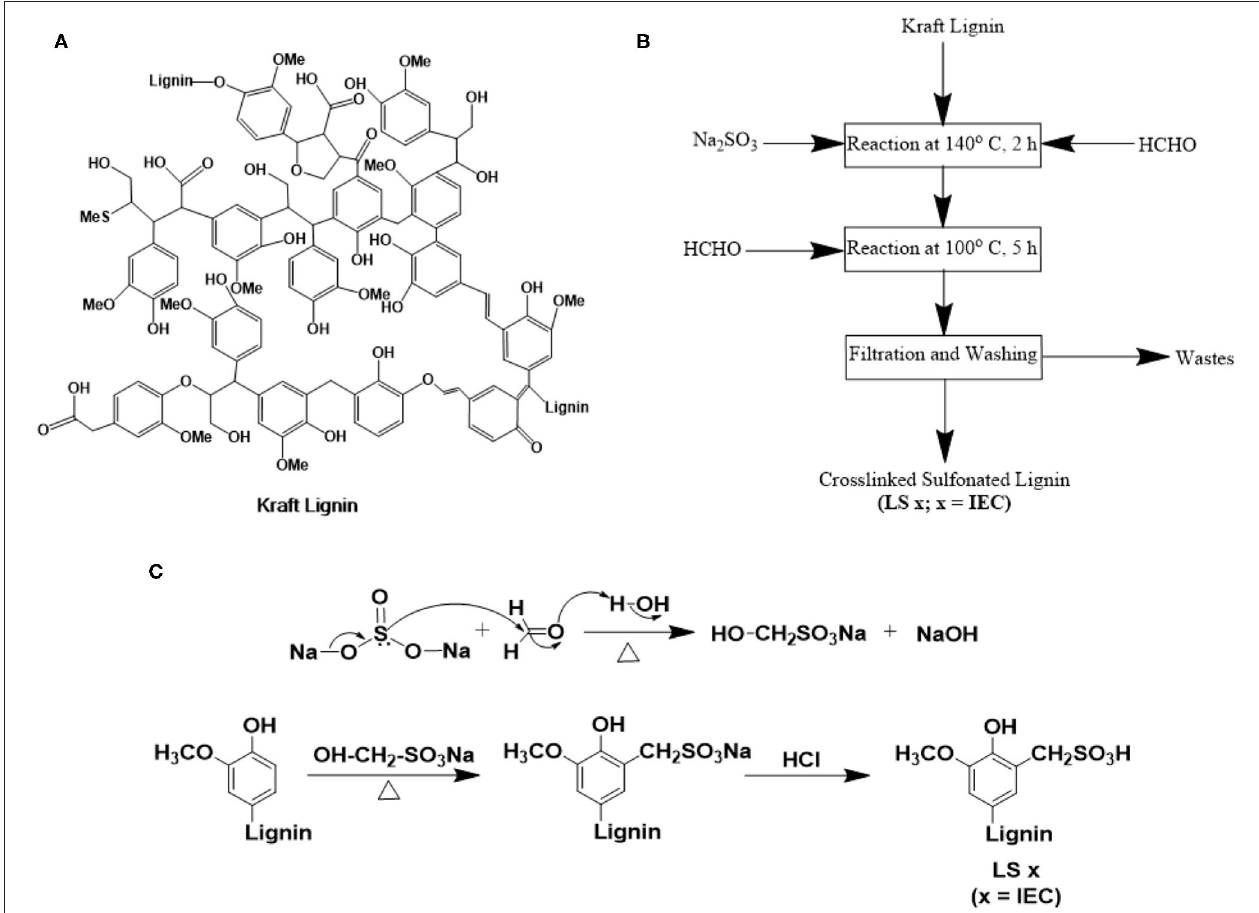
FIGURE 1 | (A) Chemical structure of kraft lignin (Lange et al., 2013); (B) step-by-step procedure; and (C) reaction mechanism of sulfonation of kraft lignin to yield lignin sulfonate ionomers (LS x, where x =